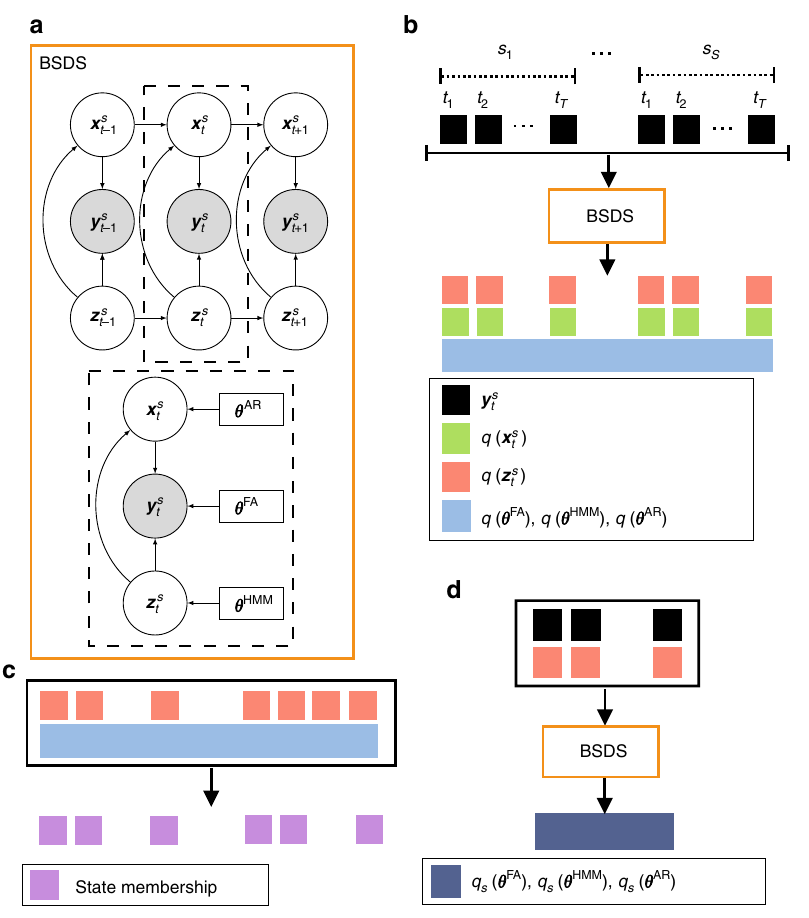
Fig. 1 The Bayesian switching dynamical systems (BSDS) model and dynamical measures. a Graphical representation of the BSDS model (see also Supplementary Fig. 1). y s t is the observed vector of ROI time series at time t for subject s , z s t denotes the latent states that are interdependent through a fi rst-order Markov chain constrained by a hidden Markov model (HMM) parameterized by θ HMM . In any given state, observations y s generated from a factor analysis (FA) model where θ FA indicates FA model parameters and x s t are the latent space variables (factor source variables) of the model. Latent variables are further assumed to be generated using an autoregressive (AR) model, where θ AR indicates the AR model parameters (Methods). b Group-level application of BSDS in which all model parameters, including number of states, are learned primarily from the data. BSDS takes sequences of ROI time series from all subjects as input data. The output of the model is the posterior distribution of all group model parameters, q θ HMM